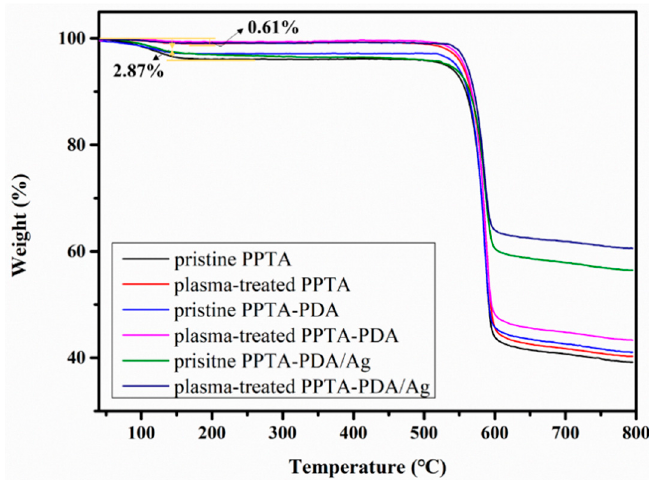
Figure 6. Thermogravimetric analysis of pristine PPTA fibers, plasma-treated PPTA fibers, dopamine functionalized PPTA fibers and silver-coated PPTA fibers (AgNO 3 concentration was 20 g / L).